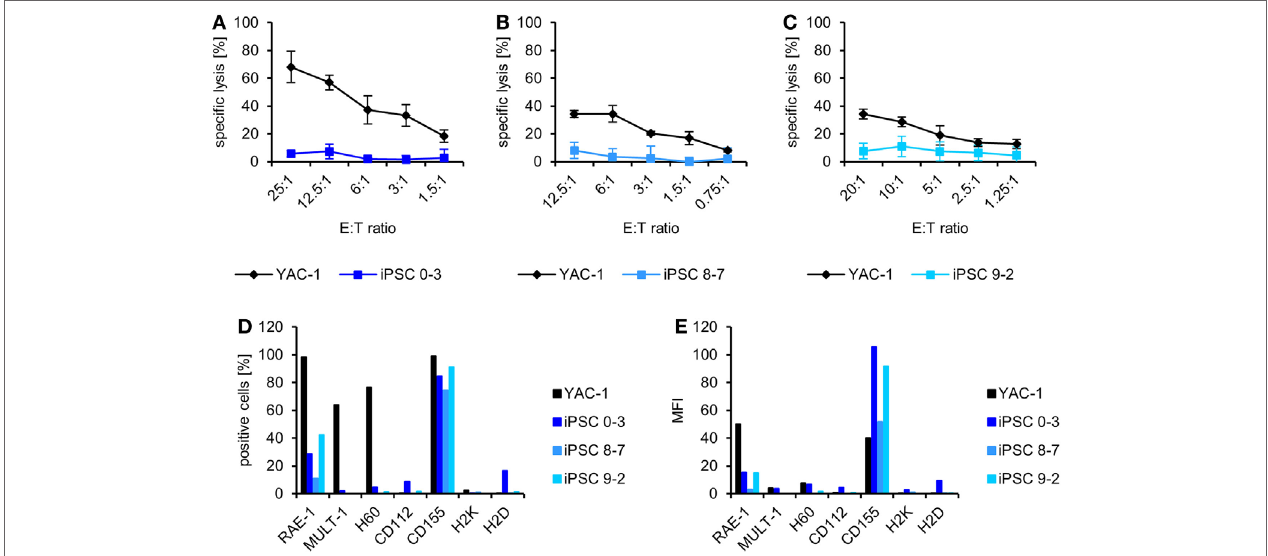
FigUre 2 | Natural killer (NK) cells of mice injected with autologous induced pluripotent stem cell (iPSCs) do not kill the respective iPSC line ex vivo . (a) Means and SD of triplets are displayed of the specific lysis of YAC-1 and iPSC 0–3 cells by NK cells derived from the donor mouse of this iPSC line, which had been injected with these cells and developed a teratoma. (B) Means and SD of triplets are shown of the specific lysis of YAC-1 and iPSC 8–7 cells by NK cells derived from the donor mouse of this iPSC line, which had been injected with these cells and developed no teratoma. (c) Means and SD of triplets are displayed of the specific lysis of YAC-1 and iPSC 9–2 cells by NK cells derived from the donor mouse of this iPSC line, which had been injected with these cells but developed no teratoma. (D) In parallel to the 51 Cr-release assays, shown in panels (a–c) , the expression of ligands of activating and inhibitory NK receptors was determined by flow cytometry and the percentage of cells expressing the indicated ligands is shown. (e) The expression intensity of the ligands is displayed as mean fluorescence intensity.